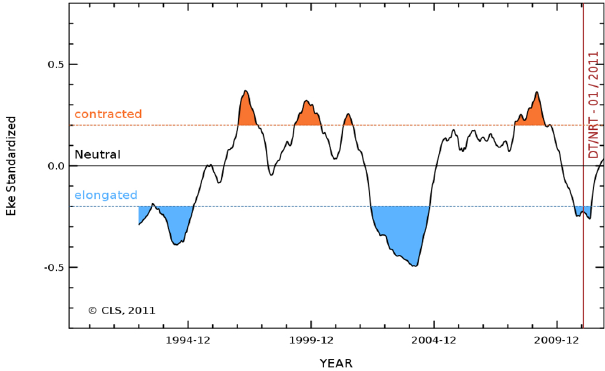
Fig. 6. Mean standardized HF-EKE defined in box B1 in the KE region during the period 1993–30 November 2011 (see Fig. 5 for B1 spatial location). Blue shaded areas correspond to elongated state periods, while orange shaded areas fit contracted state periods. The vertical red line indicates the transition between the Delayed Time (DT) and the Near Real Time (NRT) production modes of the SLA used for the HF-EKE